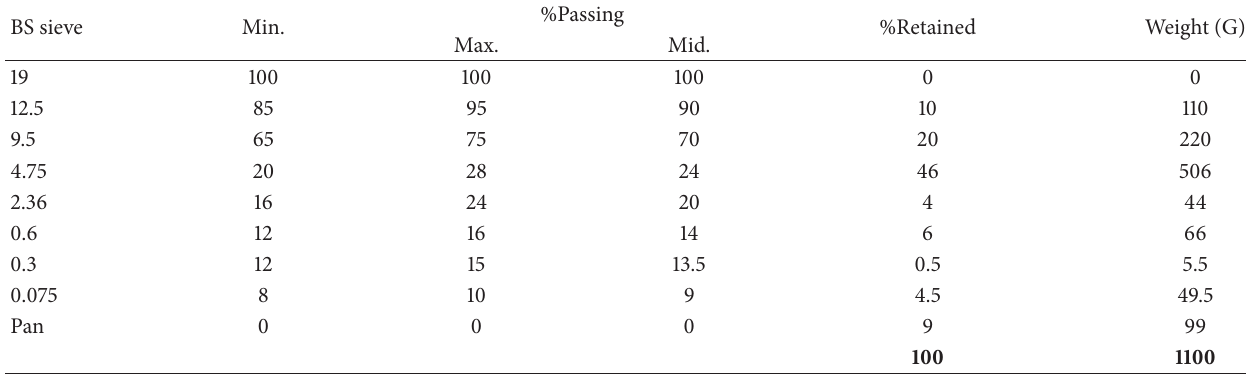
Table 3: SMA 20 aggregate gradation [4].